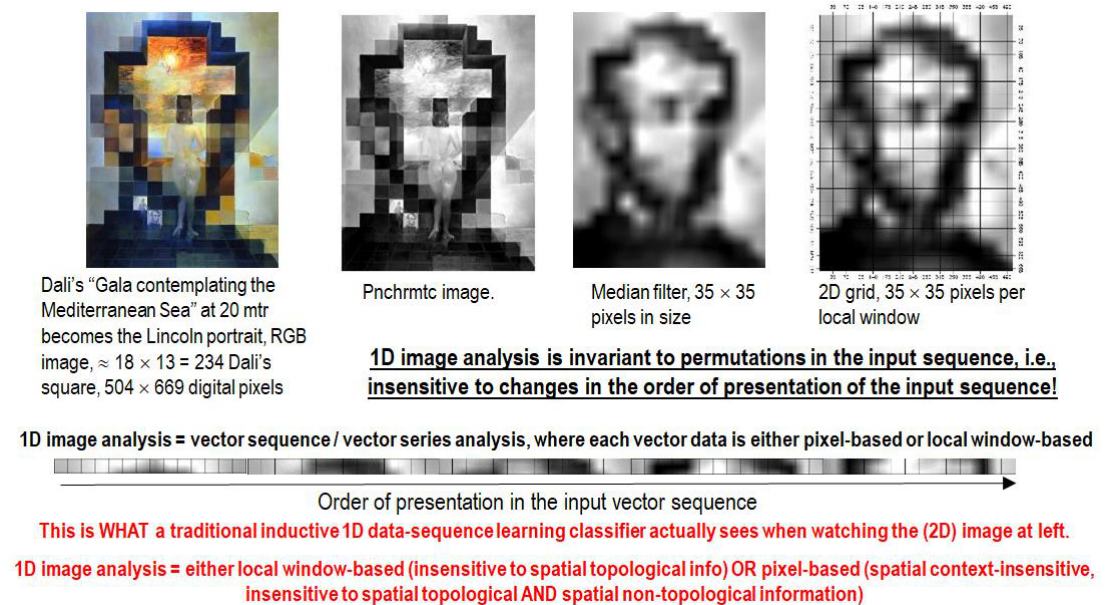
Figure 15. Example of 1D image analysis, which is spatial topology non-preserving (non-retinotopic) in a (2D) image-domain [13,87,88,96,170]. Intuitively, 1D image analysis is insensitive to permutations in the input data set [34]. Synonym of 1D analysis of a 2D gridded data set, 1D image analysis is affected by spatial data dimensionality reduction. The (2D) image at left is transformed into the 1D vector data stream (sequence) shown at bottom, where vector data are either pixel-based or spatial context-sensitive, e.g., local window-based. This 1D vector data stream means nothing to a human photo interpreter. When it is input to either an inductive learning-from-data classifier or a